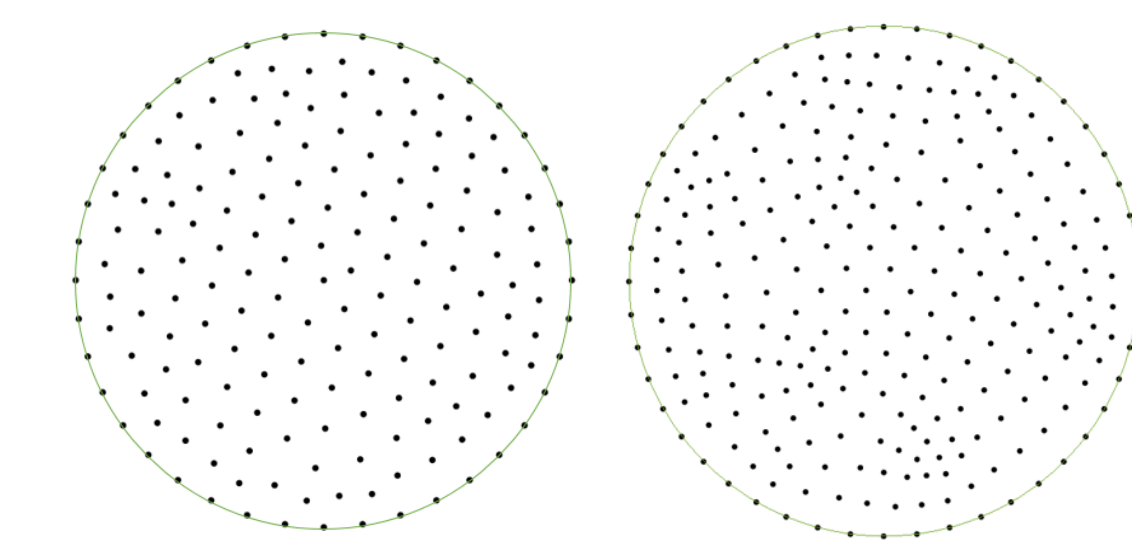
Figure 11. Offset-Ring-and-Plug Sample. The figure on the left shows a uniform data points set containing N = 260. The figure on the right shows a scattered data points set containing N = 261 non-uniform spaced nodes on the sample geometry.